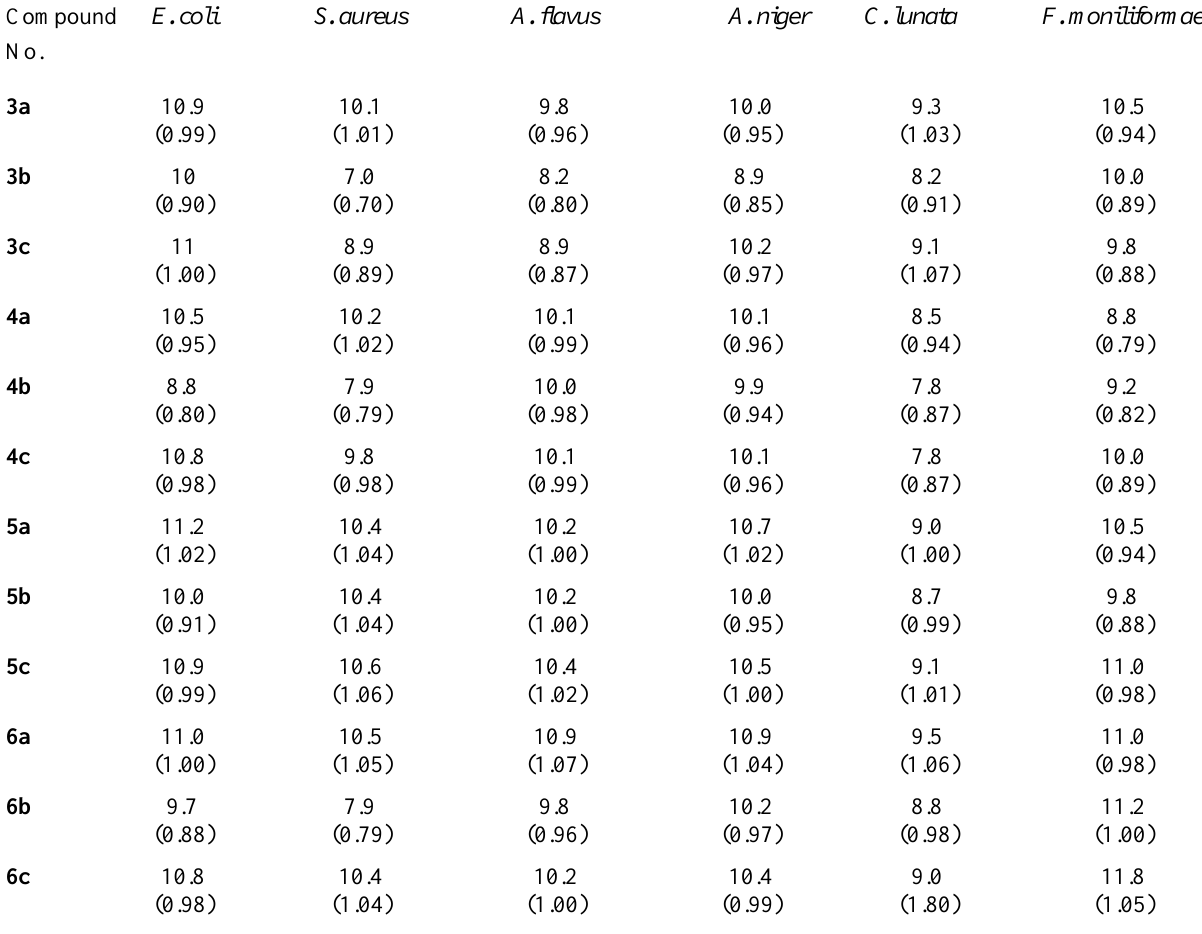
Table 4. Antimicrobial activity of 1,5-benzothiazepine derivatives: Zone of inhibition (mm) (activity index)*.